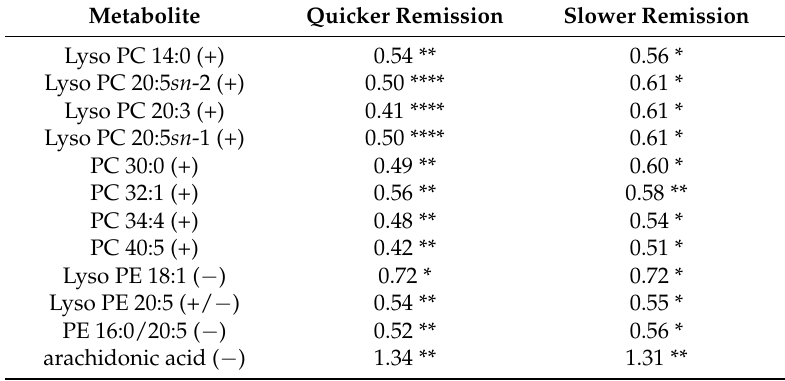
Table 2. Metabolites altered similarly before and one month after the surgery in patients with quicker and slower type 2 diabetes (T2DM) improvement detected with liquid chromatography coupled with mass spectrometry (LC-MS).